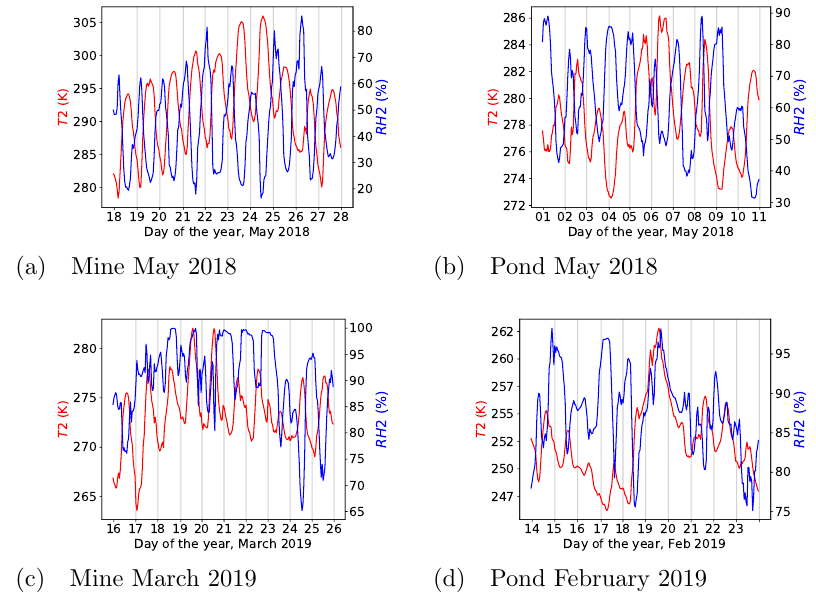
Figure A2. Time series of simulated temperature at 2 m ( T 2) and Relative Humidity at 2 m ( RH 2); numbers on the horizontal axis indicate the start of day using local standard time (LST = UTC − 7); ( a ) Mine May 2018; ( b ) Pond May 2018; ( c ) Mine March 2019; ( d ) Pond February